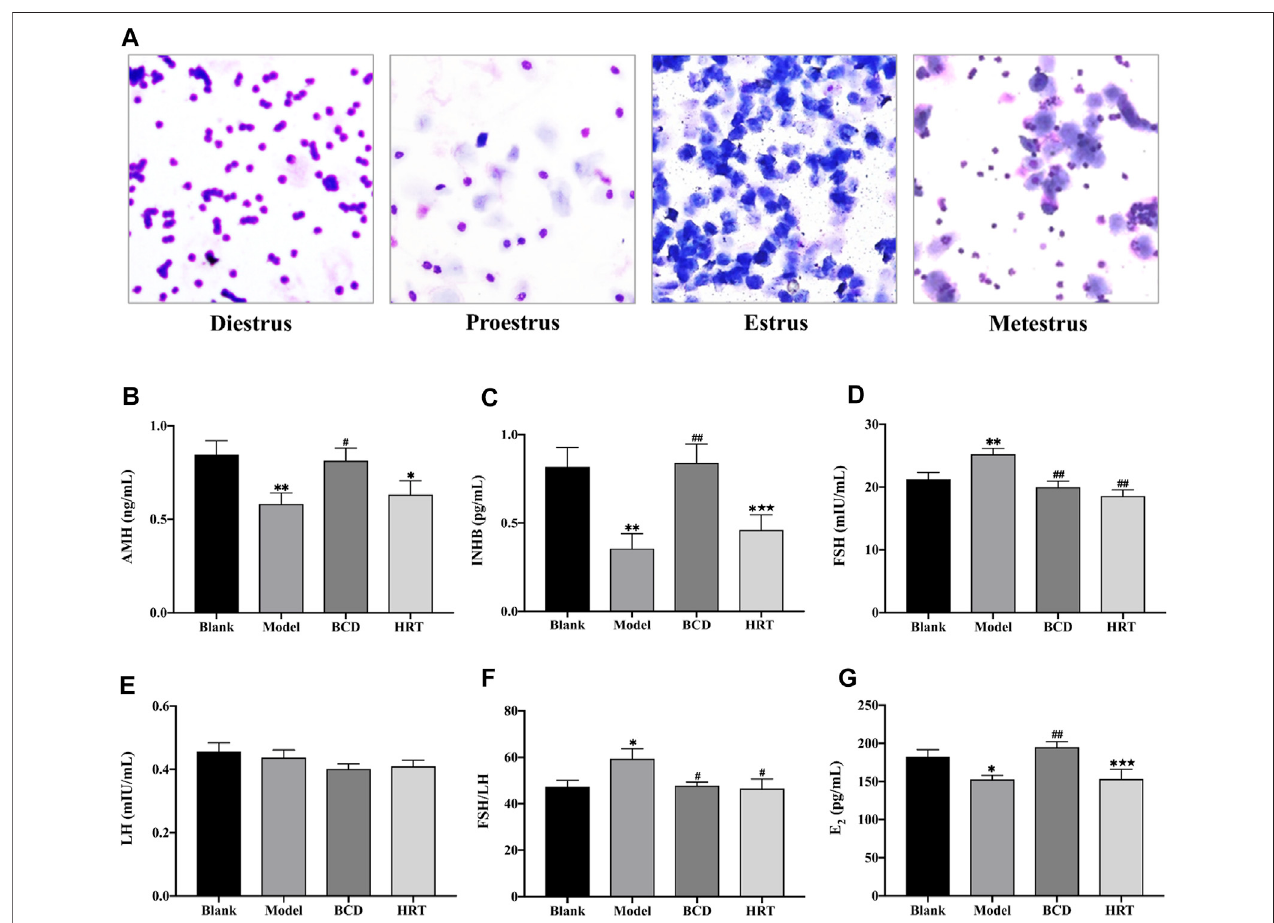
FIGURE3| BCDnormalizesestrouscyclingandserum sexhormones. (A) Representativeimages oftheestrouscyclephases. Brie fl y,diestrusissuggestedwitha signi fi cantproportionofleukocytes,proestrusbyprimarilynucleatedepithelialcells,estrusbycorni fi edepithelialcells,metestrusbyleukocytes,nucleatedepithelialcells, and corni fi ed epithelial cells. BCD augments serum sex hormone levels in TWP-enhanced POImice, and (B) AMH, (C) INHB, (D) FSH, (E) LH, (F) TheratioofFSH to LH and (G) E 2 serum concentrationwereevaluatedusingELISA.Dataisvisualized inmeans±SEM.( n =8,* p < 0.05,** p < 0.01,compared withtheBlank group; # p < 0.05, ## p < 0.01, compared with the Model group; + p < 0.05, ++ p < 0.01, compared with the BCD